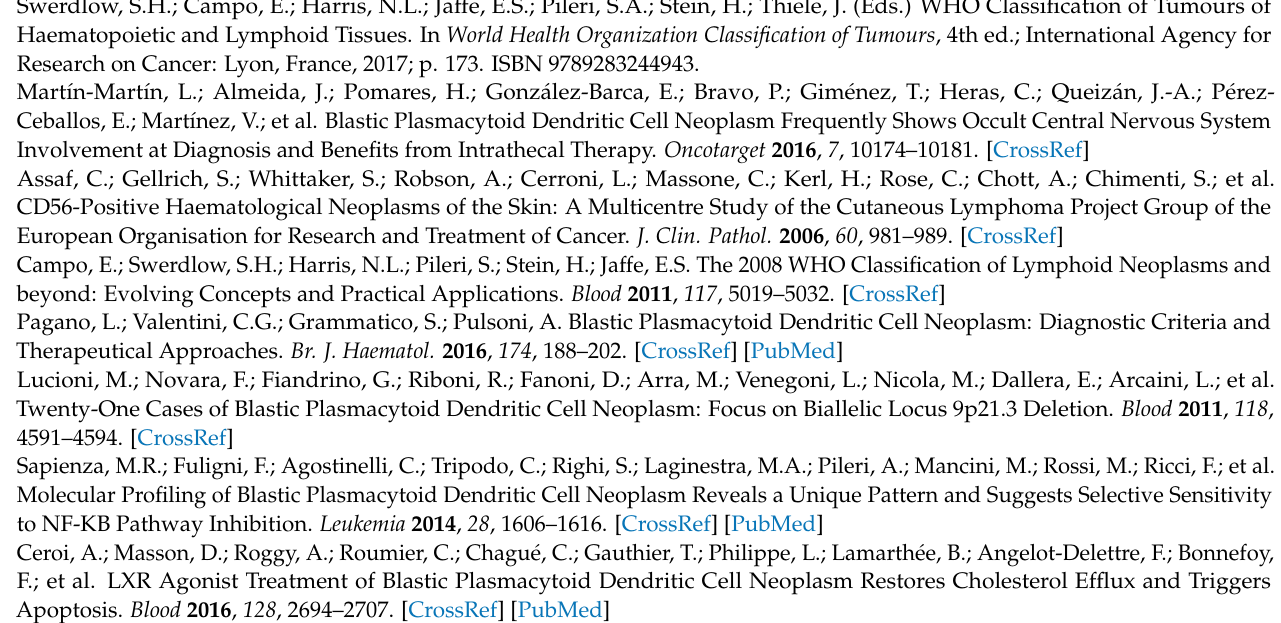
for neural markers in BPDCN, Table S1: Clinical characteristics of discovery set patients, Table